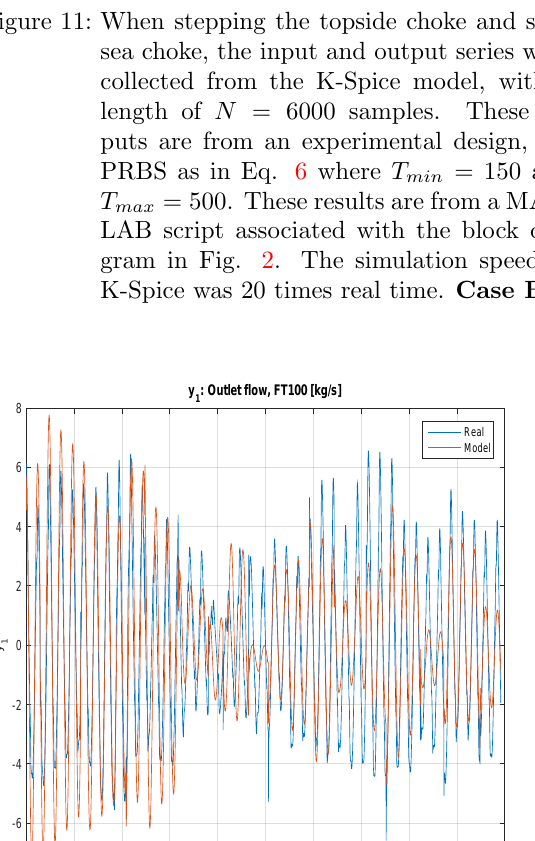
Figure 14: Open-loop simulations in K-Spice. We ob- serve how the amplitudes are increasing as the topside choke is increasing. Note that 2000 ≤ Time ≤ 4000 is a marginally stable region. Case